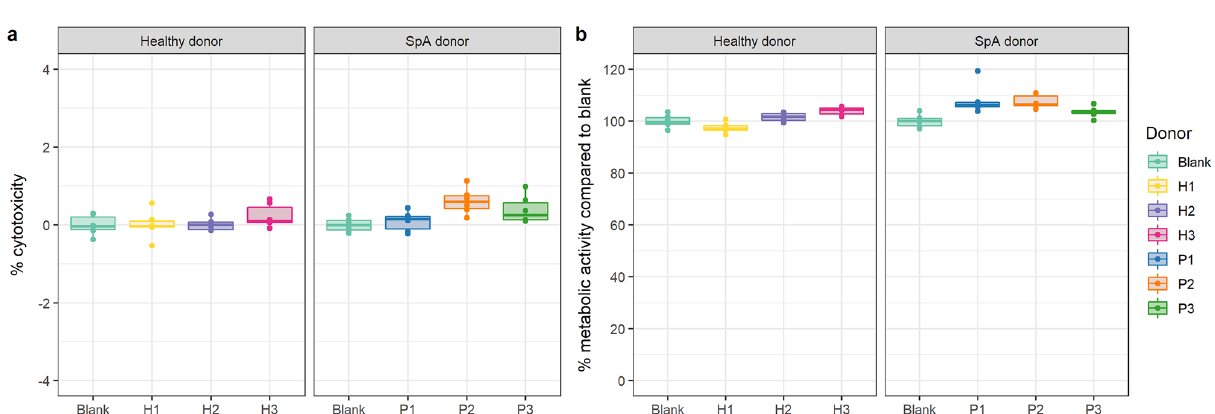
Figure 2. Triple cocultures are robust against exposure to fecal microbiota from healthy and SpA donors. ( a ) Cytotoxic stress as measured by LDH assays. ( b ) Metabolic activity compared to the blank condition (not exposed to bacteria) as measured by a resazurin reduction assay (n =